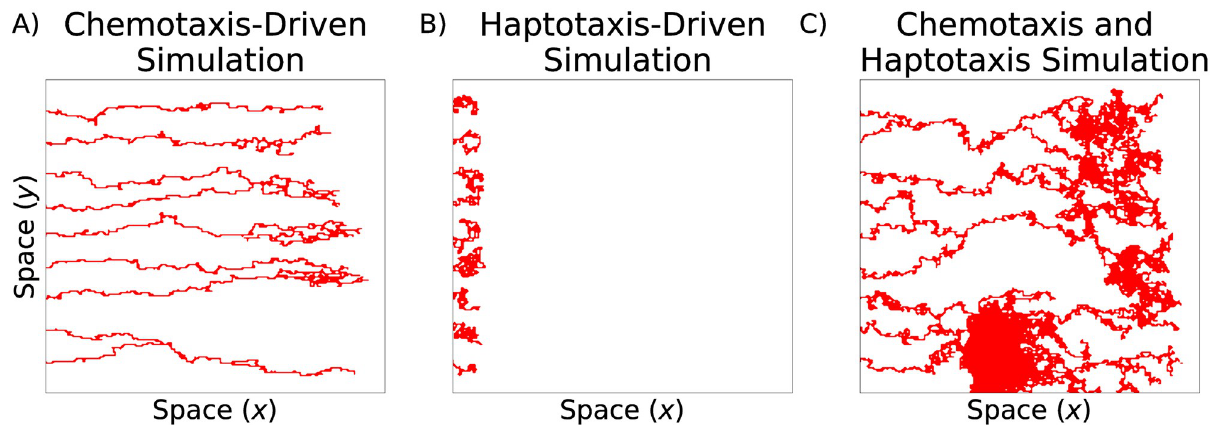
Fig 7. Typical realizations of the Anderson-Chaplain model. A) Chemotaxis-driven tip cell movement ( ρ = 0.00, χ = 0.50), B) haptotaxis-driven tip cell movemement ( ρ = 0.50, χ = 0.00), and C) tip cell movement driven by chemotaxis and haptotaxis ( ρ = 0.15, χ = 0.15).